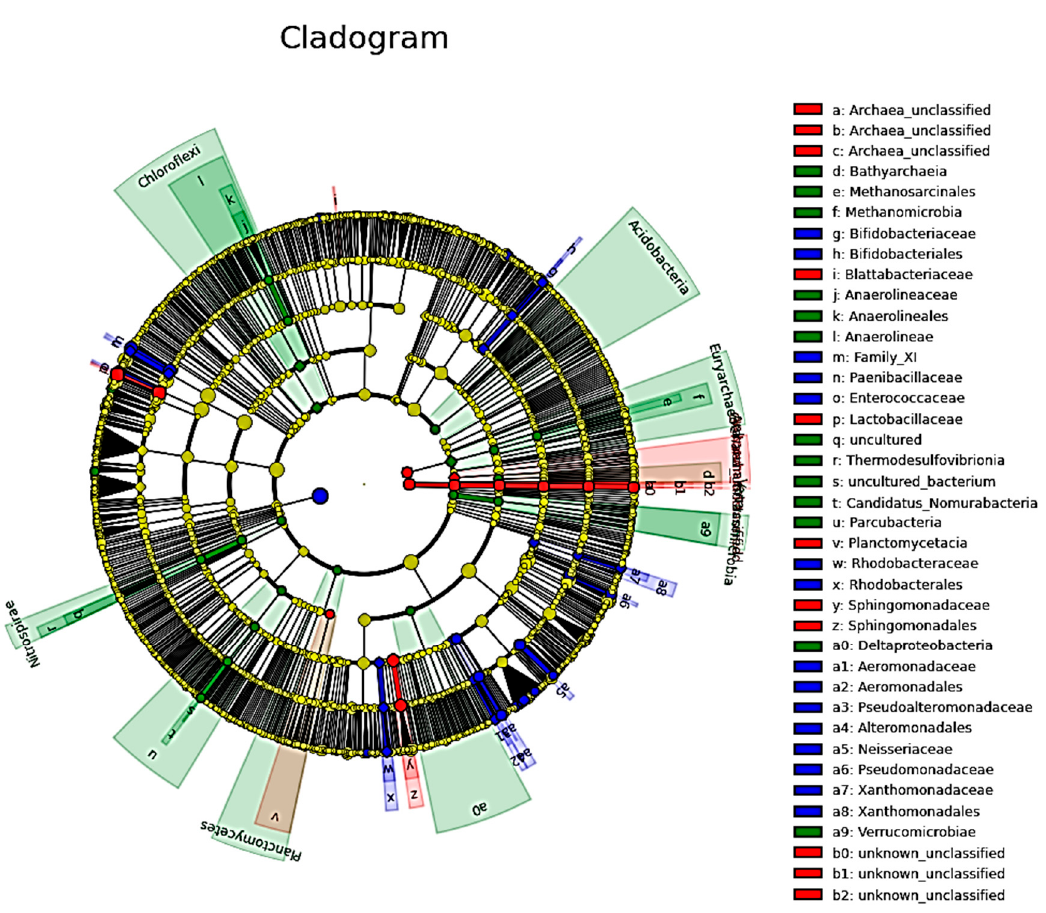
Figure 3. Different abundant microbial taxa between two “doing-the-month” and one “non-doing- the-month” milk groups revealed using Cladogram, which analyzed using the Linear discriminant analysis effect size (LEfSe). The keys for milk-H, milk-PCA, and milk-PCB are described in Table 1. Briefly, milk-H ( n = 46): “non-doing-the-month” milk group; milk-PCA ( n = 14) and milk-PCB ( n = 27): “doing-the-month” milk group. Graphs and bacterial members that are more enriched in milk-H (blue color), milk-PCA (green color), and milk-PCB (red color) are shown.